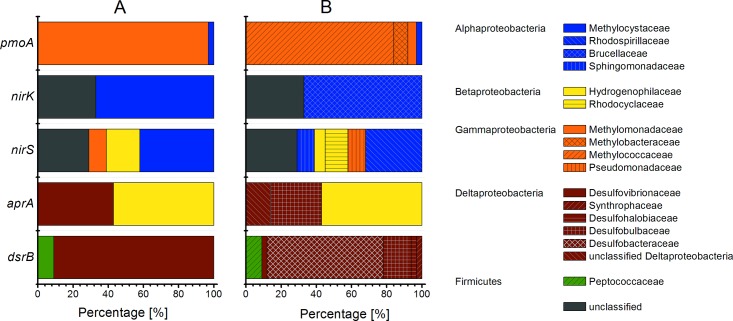
Bar chart of analyzed functional genes and their phylogenetic classification.(A) Phylum-level classification of functional gene sequences; (B) Phylogenetic classification of the sequences to their closest related family. Colors correspond to encountered phyla, while patterns indicate families.